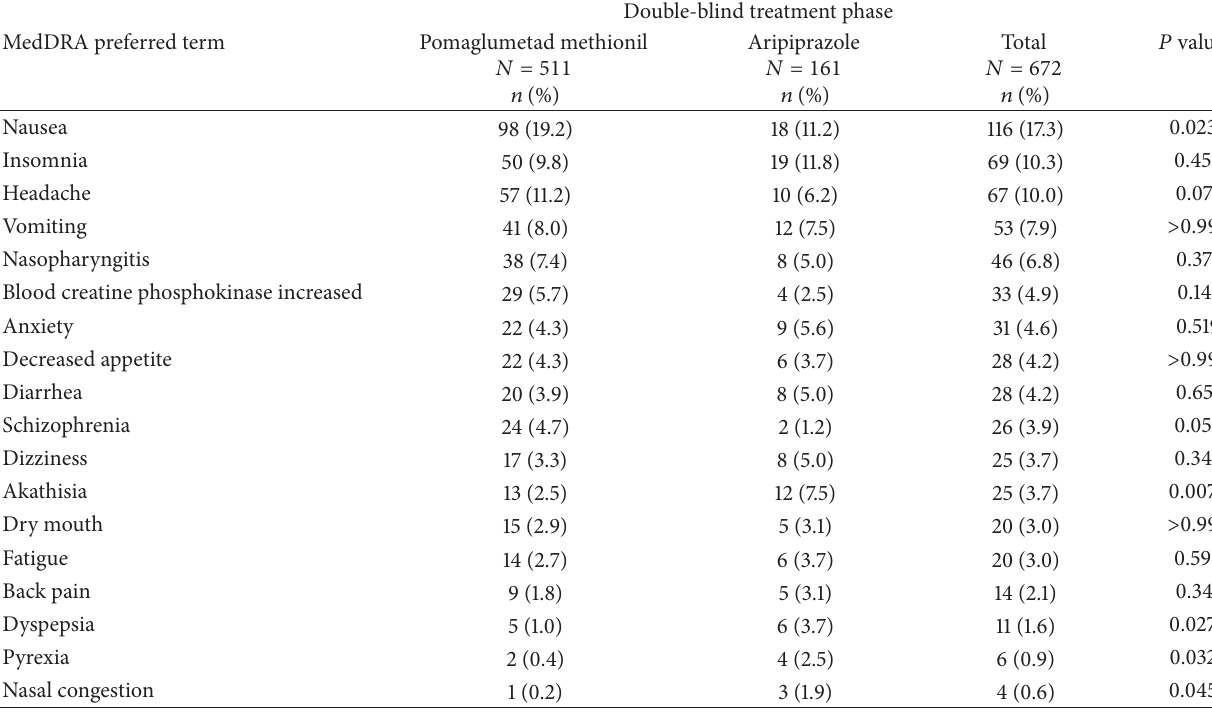
Table 3: Incidence of most common treatment-emergent adverse events ≥ 3% in any treatment group and/or with statistically significant treatment difference, by preferred